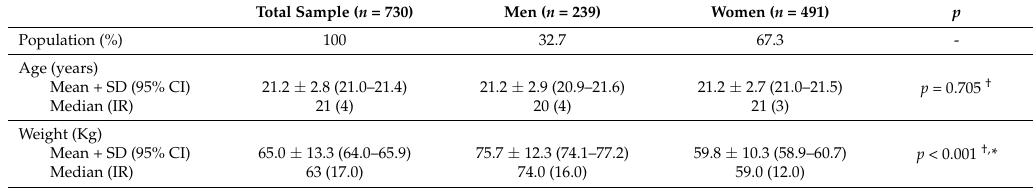
Table 1. Sociodemographic, anthropometric and lifestyle characteristics of the subjects (total sample). Total Sample ( n =